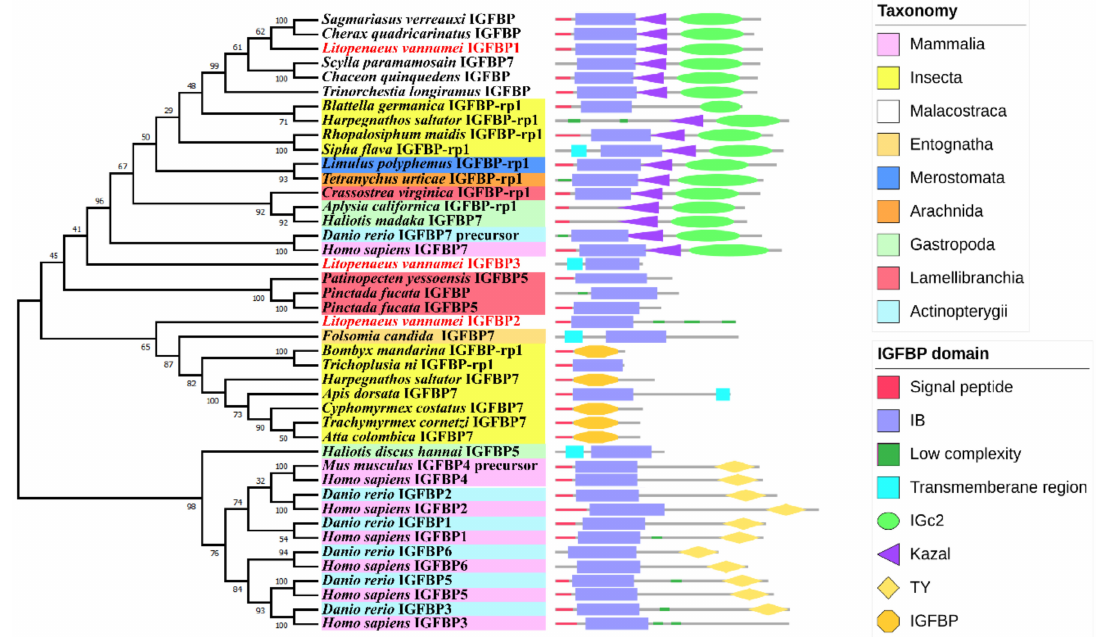
Figure 1. Phylogenetic tree of insulin-like growth factor binding proteins (IGFBPs) and their gene structures. The domains of IGFBPs obtained from the SMART program are located on the right of the phylogenetic tree. The bootstrap values are given at each branch